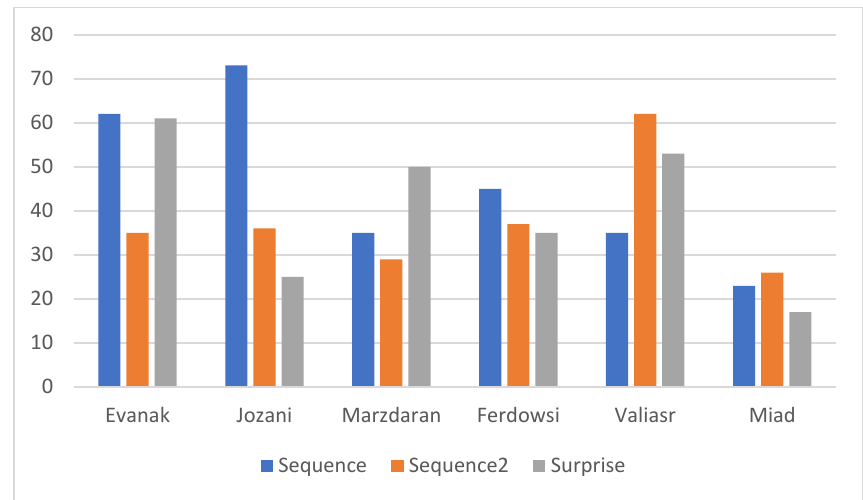
Chart 3. Comparison of streets in the cognitive criterion (Source: Authors).